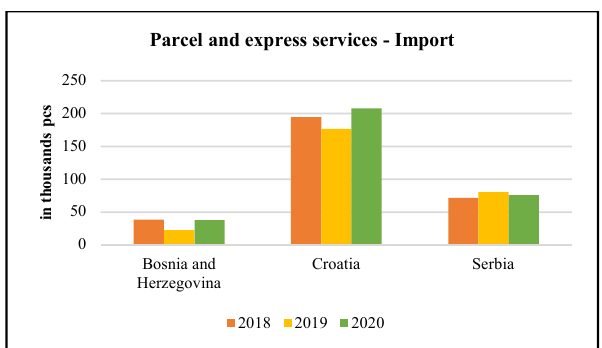
Figure 3. Parcel and express services in Import - PPO.